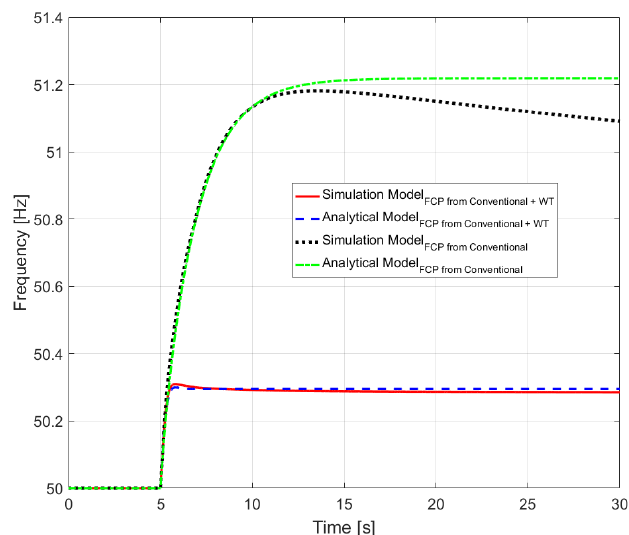
Figure 17. Analytical and Simulation Model for 40% wind penetration.